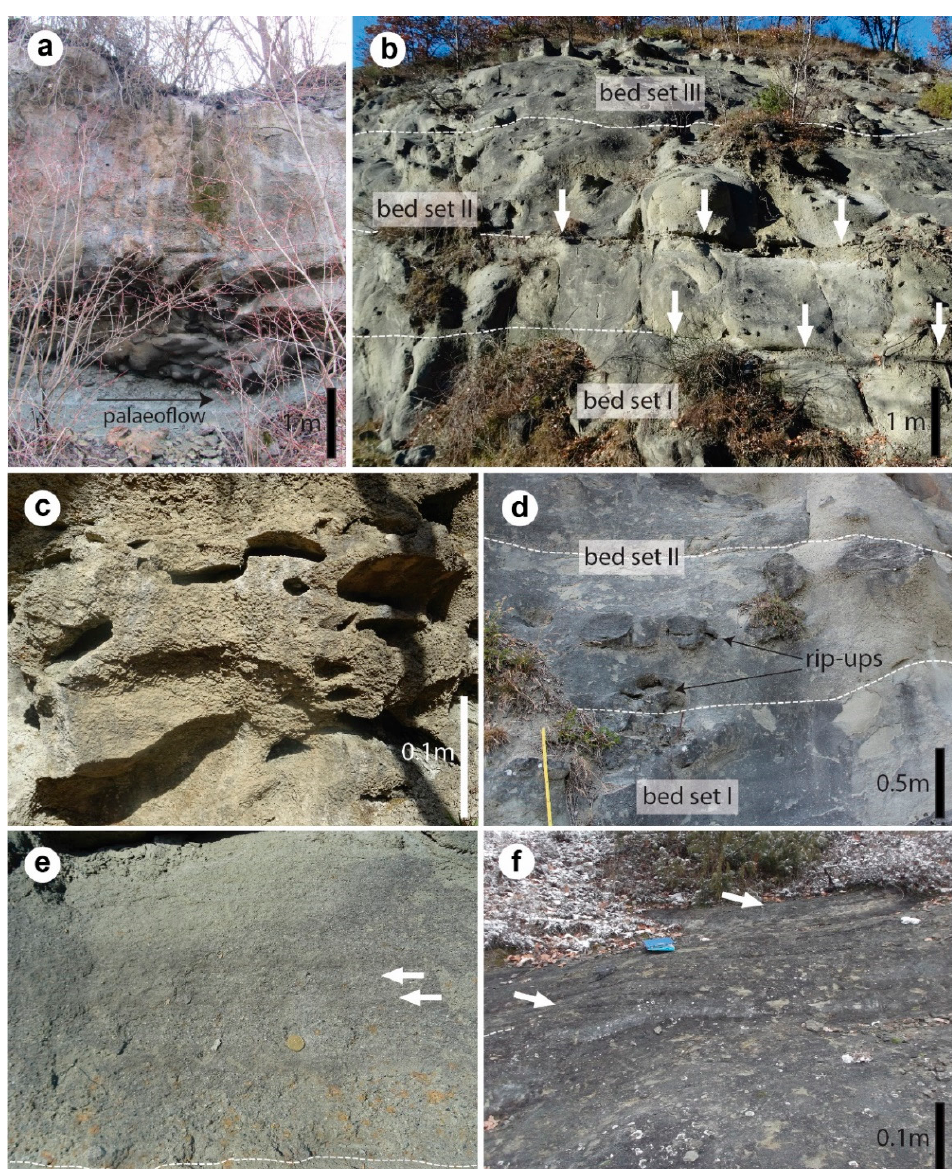
Figure 4. ( a ) Flute casts from the channel ‐ fill base in log 1 indicating average palaeoflow toward W ‐ NW (see Figure 3a). Note the well ‐ cemented nature of the lowermost part of CdV; ( b ) amalgamation surfaces (dashed lines) passing laterally (to the right, i.e., toward the channel margin) to preserved turbidite mud caps (arrows); ( c ) Large marlstone rip ‐ ups within completely cemented sandstone bed from the lowermost part of CdV; ( d ) Amalgamated sandstone beds with a range of faint to well ‐ developed parallel lamination; ( e ) coarse infill of a basal scour with mm ‐ scale marlstone rip ‐ ups surrounded by a yellowish weathering aura, followed upward by traction carpets (arrows); ( f ) Arrows indicate medium ‐ (below) to small ‐ (above) scale bed forms from the upper part of bed set IV (paleoflow toward the right). Note the poorly cemented nature of the deposit.